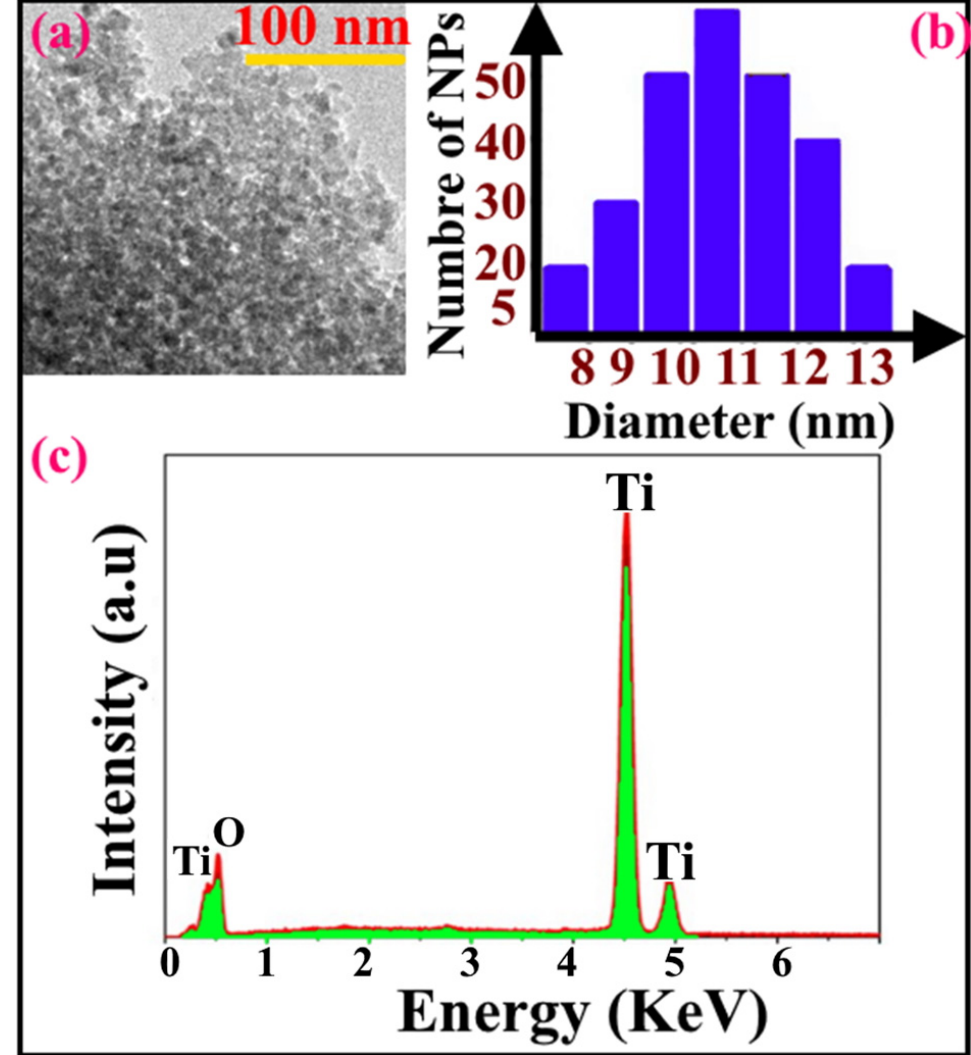
Figure 3. ( a ) TEM image, ( b ) particle size distribution and ( c ) EDX spectrum of TiO 2 nanoparticles.